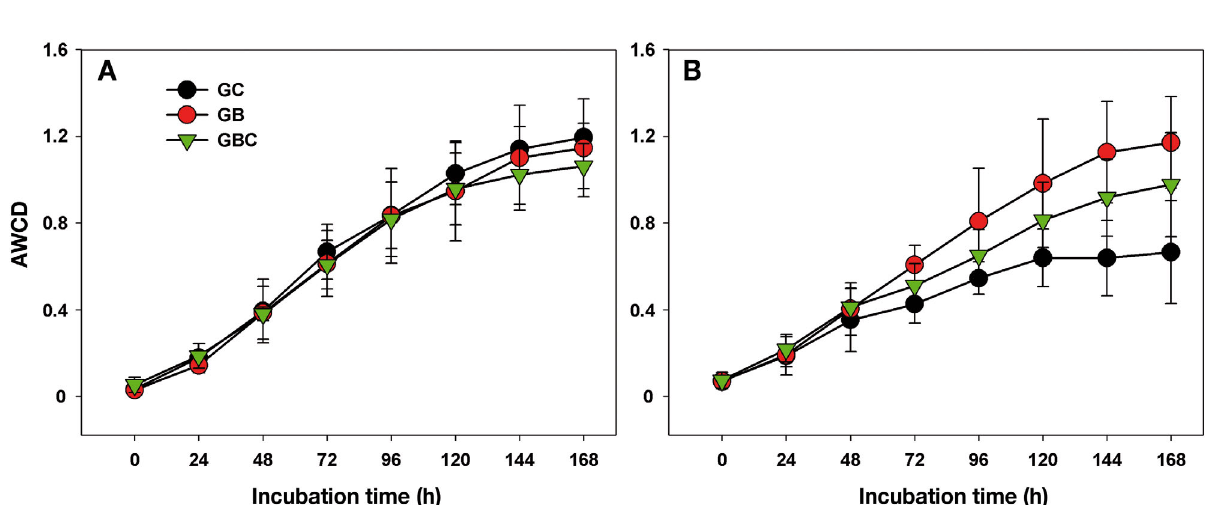
Fig. 4. Metabolic activity of the bacterial community in different treatment groups (see Table 1) on (A) Day 28 and (B) Day 56 . AWCD: average well color development. Data are mean ±